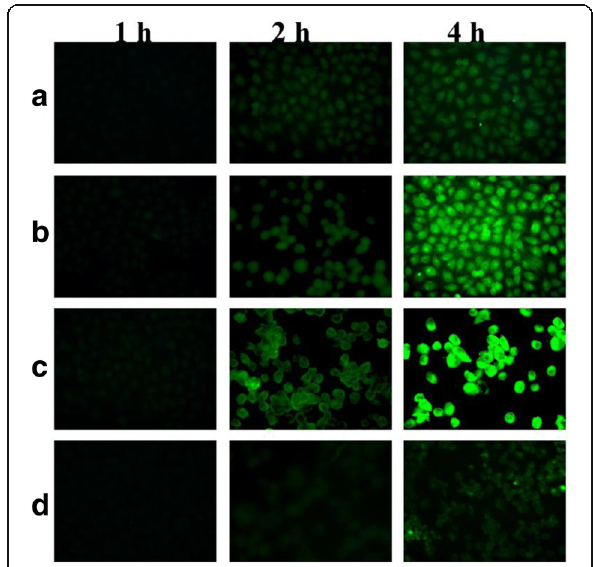
Fig. 7 Fluorescence microscopy images of the cellular uptake of free Cur ( a ), oHA-Cur/ Cur-micelles ( b ), and TPP-oHA-S-S-Cur/Cur-micelles ( c ) at different time. d Cells treated with TPP-oHA-S-S-Cur/Cur-micelles in the presence of free HA (2 mg/mL), showing the completion effect of HA in MDA-MB-231